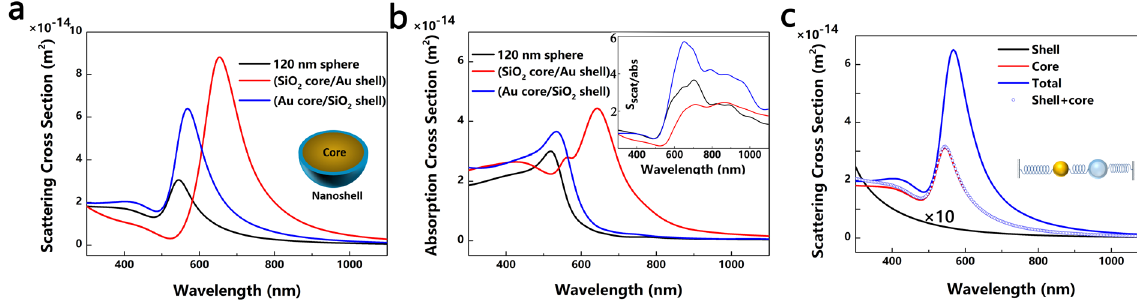
Figure 2. Scattering ( a ) and absorption ( b ) spectra of the single core-shell nanosphere calculated per Mie theory. A medium of index 1 was used in background. The inset in ( b ) is the scattering-to-absorption ratio S , indicating that the core-shell nanostructure has broadband external field enhancement which exceeds parasitic absorption. The diameter of the core is set as 120 nm and the thickness of the coating shell t is 15 nm. ( c ) The individual scattering spectra of an Au core, a hollow SiO 2 shell, a core-shell nanosphere and the sum value of an Au core and a hollow SiO 2 shell. The inset schematically illustrates the oscillator model. The golden sphere and the blue shell stand for the Au core and the SiO 2 shell,